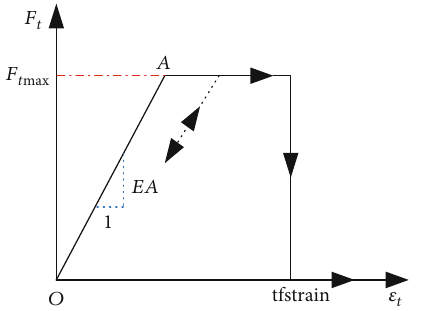
Figure 4: The tensile-rupture mechanical model of the